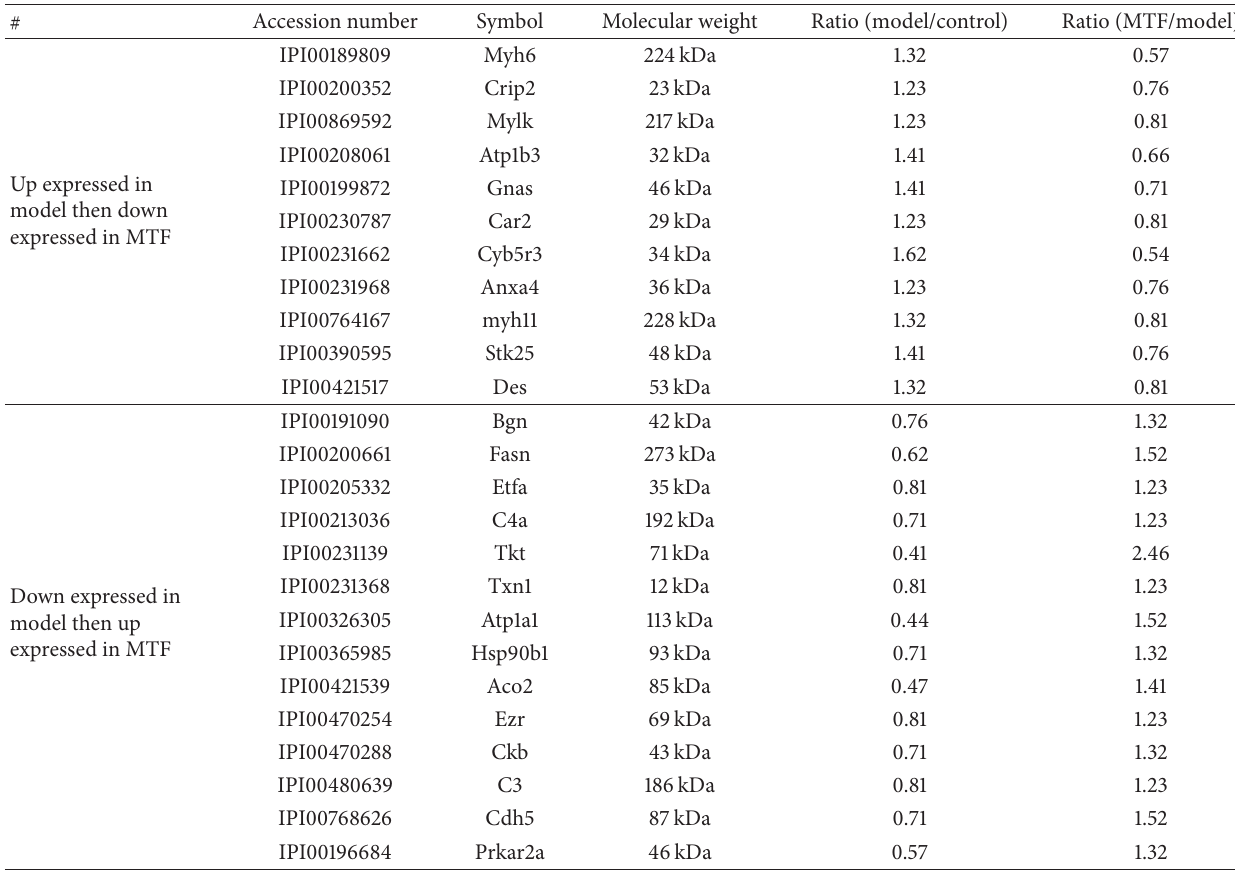
Table 1: DPs normalized by MTF treatment.